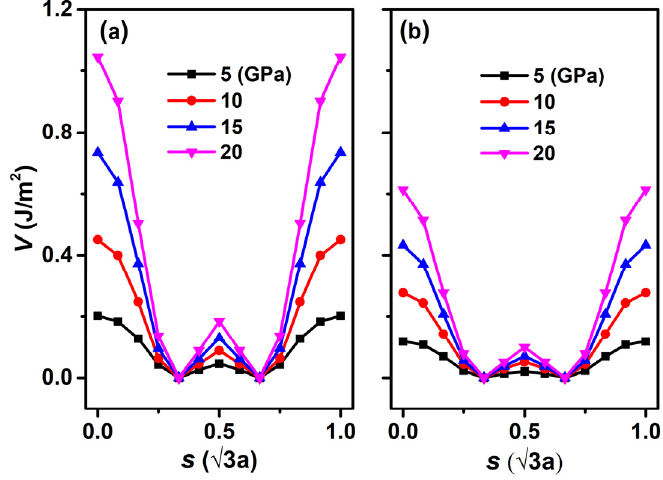
√ 3 times of lattice